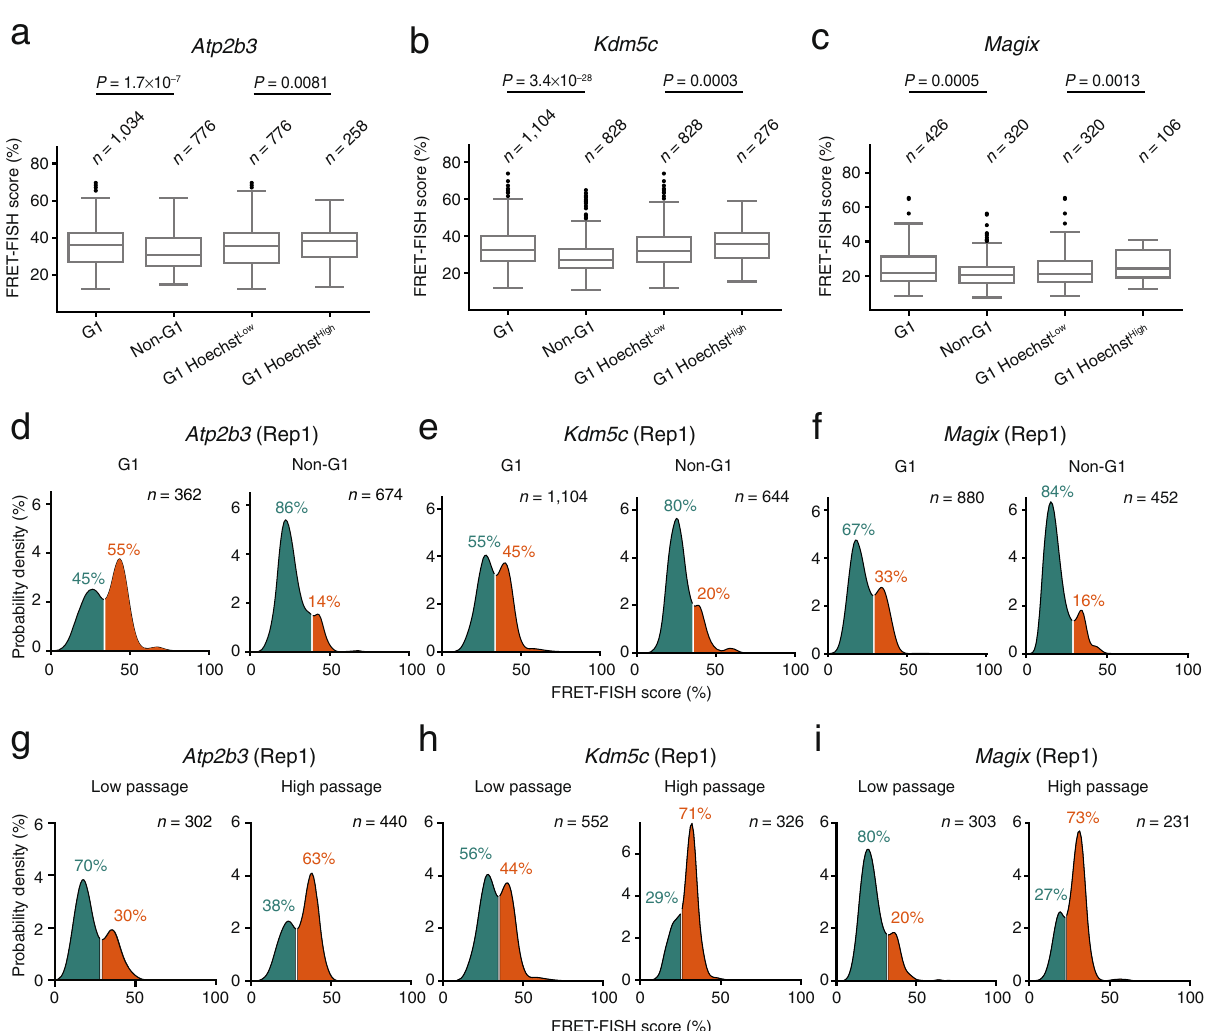
extremity of the corresponding whisker. n , number of FRET signals analyzed. P , Wilcoxon test, two-tailed. d – f FRET-FISH score distributions in G1 and non-G1 cells for the same loci shown in ( a ), in one of three replicate (Rep) experiments. The in fl ection point in each bimodal distribution was used to separate between the lower (green) and higher (orange) FRET-FISH score mode corresponding, respec- tively, to a less and more compact chromatin state. The percentages indicate the proportion of FRET signals in each group. n , number of FRET signals analyzed. g – i Same as in ( d – f ) but comparing MEFs cultured for less (Low passage) or more (High passage) than 10 passages. Source data for all the plots shown in the fi gure are provided as a separate Source Data fi